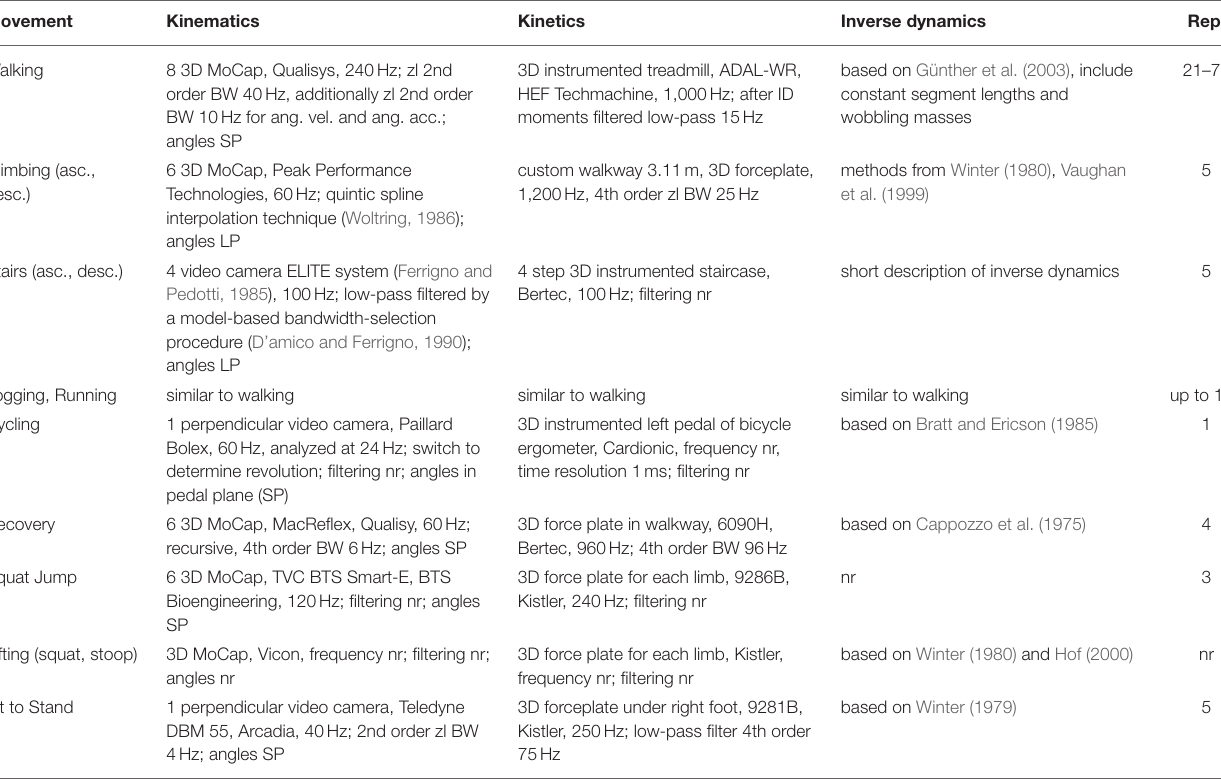
TABLE 1 | Methods and experimental setup to acquire the biomechanics for walking (Lipfert, 2010; Grimmer and Seyfarth, 2014), climbing (Lay et al., 2006), stair ambulation (Riener et al., 2002), jogging and running (Lipfert, 2010; Grimmer and Seyfarth, 2014), cycling (Ericson et al., 1986), recovery (Hsiao-Wecksler and Robinovitch, 2007), squat jump (Mackala et al., 2013), lifting (Hwang et al., 2009), and the sit to stand transition (Roebroeck et al., 1994). Movement Kinematics Kinetics Inverse dynamics